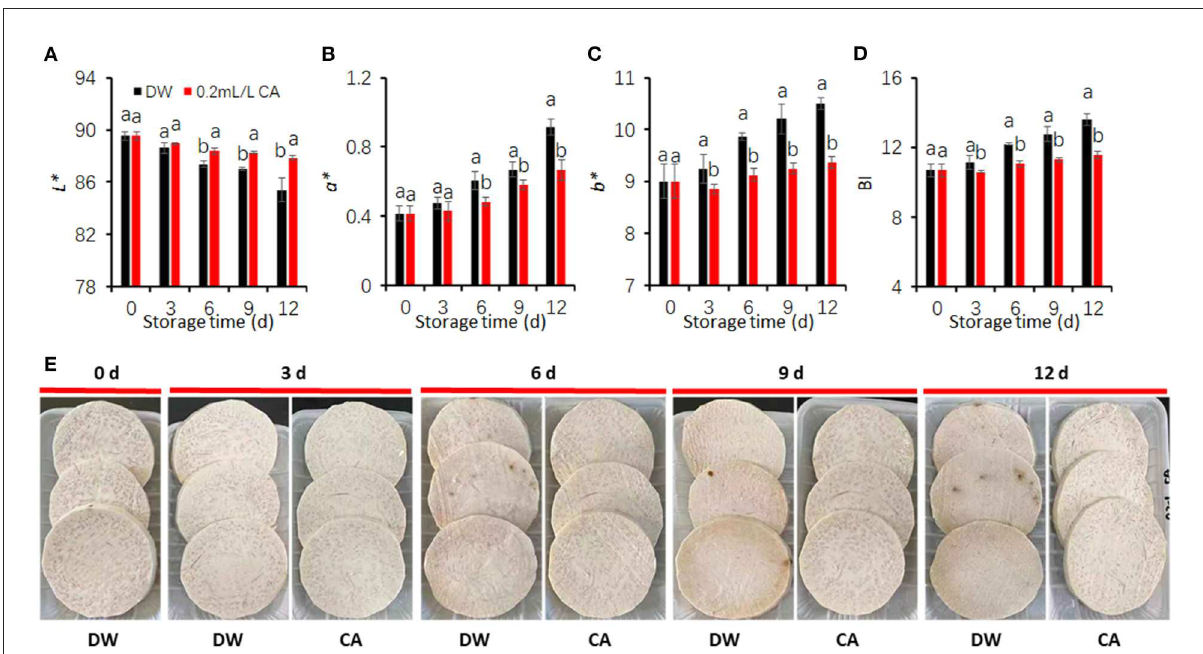
FIGURE2 Inhibitory effects of 0.2 mL/L citronellal (CA) treatment on the browning of fresh-cut taros. (A) L * value; (B) a * value; (C) b * value; (D) browning index (BI); (E) representative pictures from DW and CA treated taros during cold storage. DW, distilled water. Each value is presented as the mean ± SE ( n = 9). Statistical differences ( p ≤ 0.05) are indicated as different letters above the